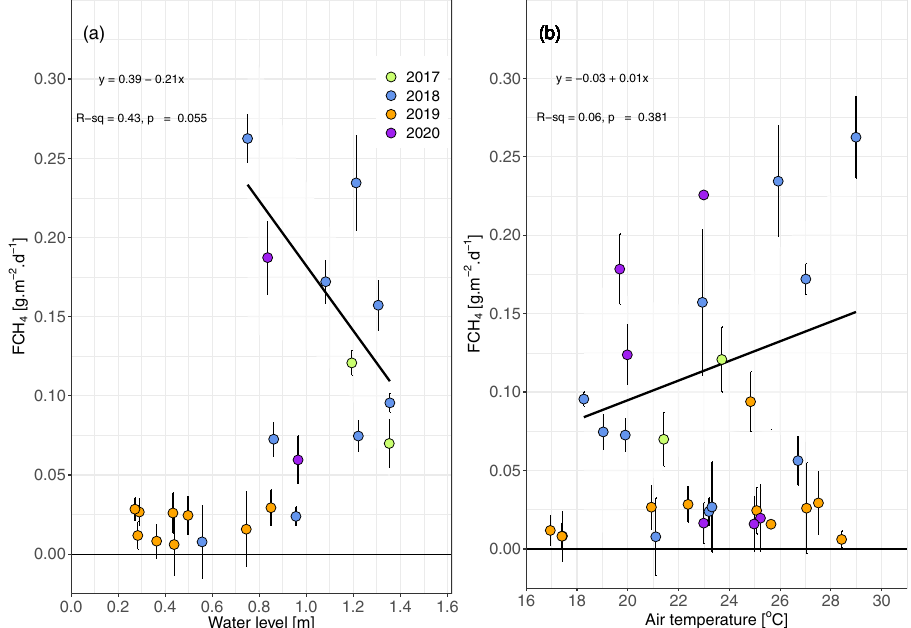
Fig. 4 Relationship between monthly methane fl uxes, water level and air temperature. Monthly median CH 4 fl uxes (FCH 4 , g m − 2 day − 1 ) ± inter-quartile range (IQR) from August 2017 to August 2020 as a function of ( a ) monthly water level, and ( b ) mean air temperature at the seasonal fl oodplain measurement site (19°32 ′ 53 ″ S; 23°10 ′ 45 ″ E). The number of half-hourly fl ux data points ( n ) from which median and IQR were calculated changed from month to month because of the variability of points fi ltered out by the micrometeorological quality control fi lter (see Methods). Consequently, n ranged from 33 (August 2020) to 570 (September 2019). The solid lines represent linear regressions on a temporal subset of the data (austral winter to summer 2017 and 2018) excluding the 2019 drought period (equations and t-test two-sided p-value given in the panels): standard error of ( a ) ±0.10 and 0.09, and ( b ) ±0.01 and 0.16 for slope and intercept,